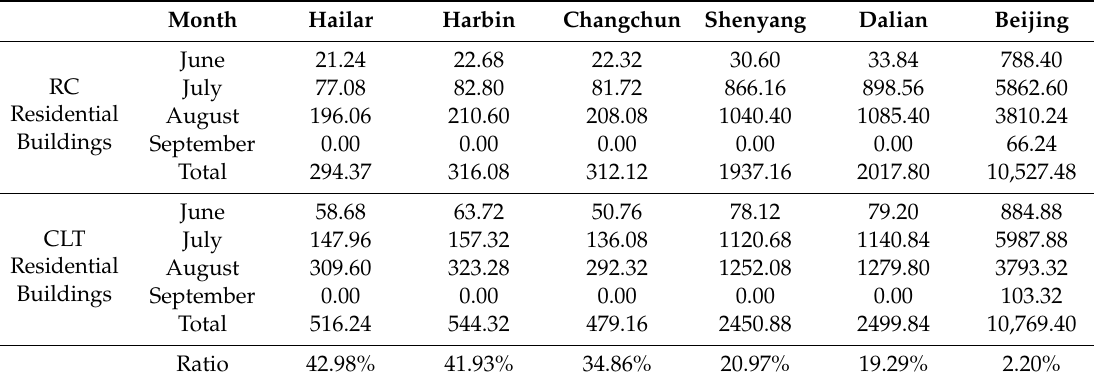
Table 10. Cooling energy consumption in the six cities (kJ / m 2